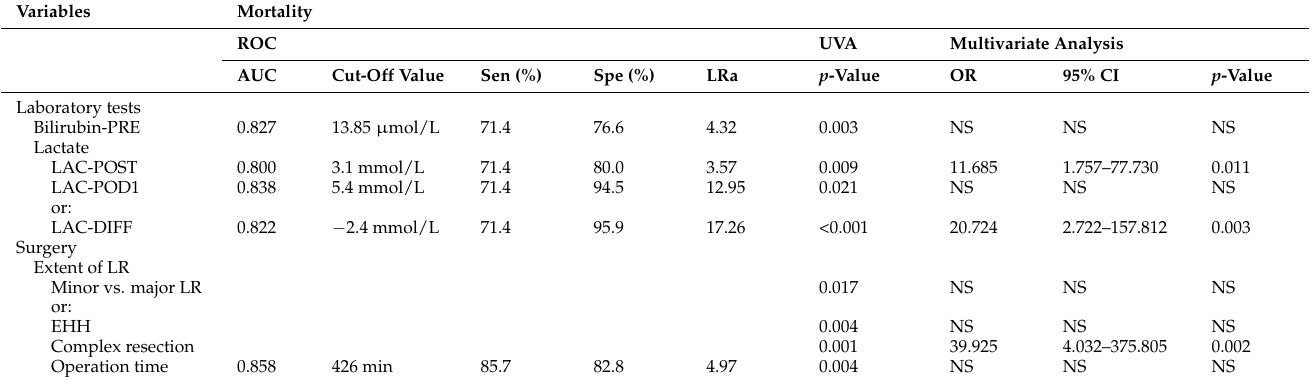
Table 5. Predictors of postoperative mortality in 152 patients undergoing liver